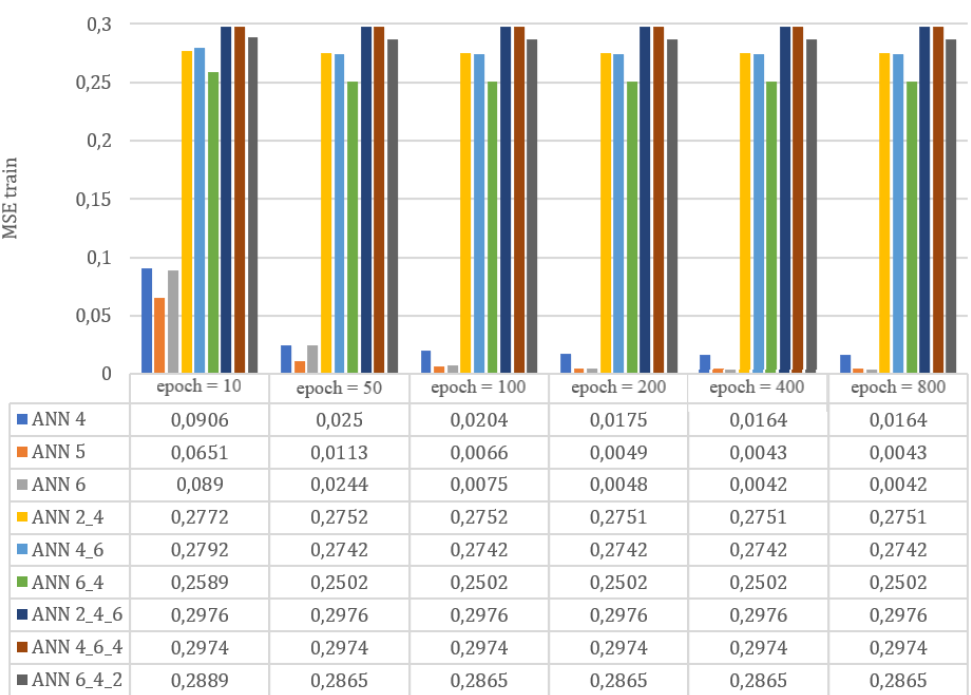
Figure 11. MSE test results of nine different ANN topologies.